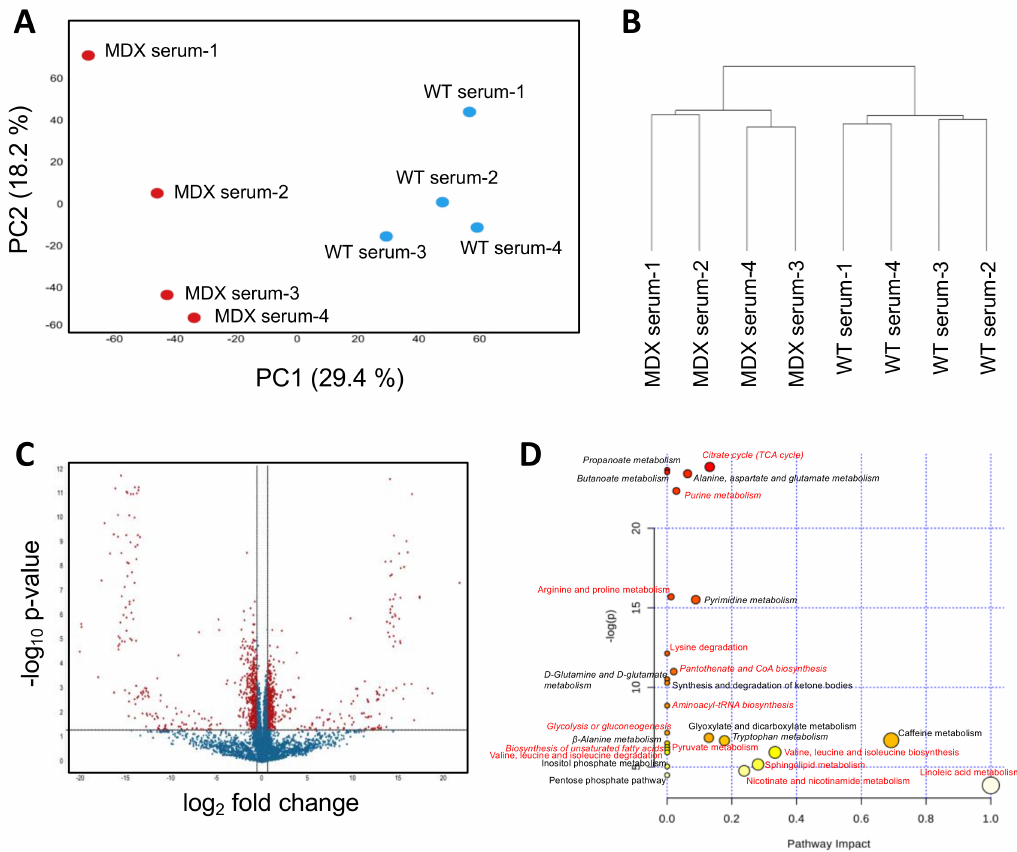
Figure 2. Serum metabolomic analysis. ( A ) A principal component analysis (PCA) plot derived from nontargeted metabolite profiling of serum isolated from four WT control and four MDX mice. ( B ) A dendrogram depicting hierarchical clustering results of samples from ( A ). Clustering method: complete linkage. Distance measurement: Euclidean. ( C ) A volcano plot depicting DAMs between WT and MDX serum. Horizontal and vertical dashed lines represent a threshold of p -value 0.05 and fold change 1.5, respectively. One-thousand-one-hundred-and-twenty-five features were identified to be significant from 9562 total features. ( D ) Pathway analysis of serum DAMs. Italics: pathways with multiple metabolites implicated. Red: metabolic pathways identified in both serum and muscle satellite cell